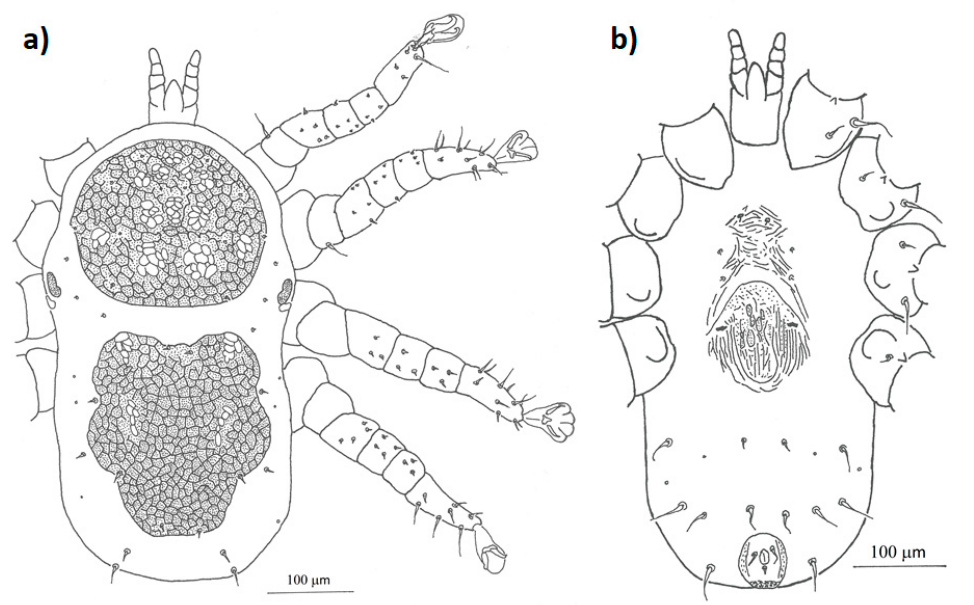
Figure 5. Detailed drawing of the morphological characteristics of female Mesonyssus streptopeliae : ( a ) dorsal view; ( b ) ventral view.